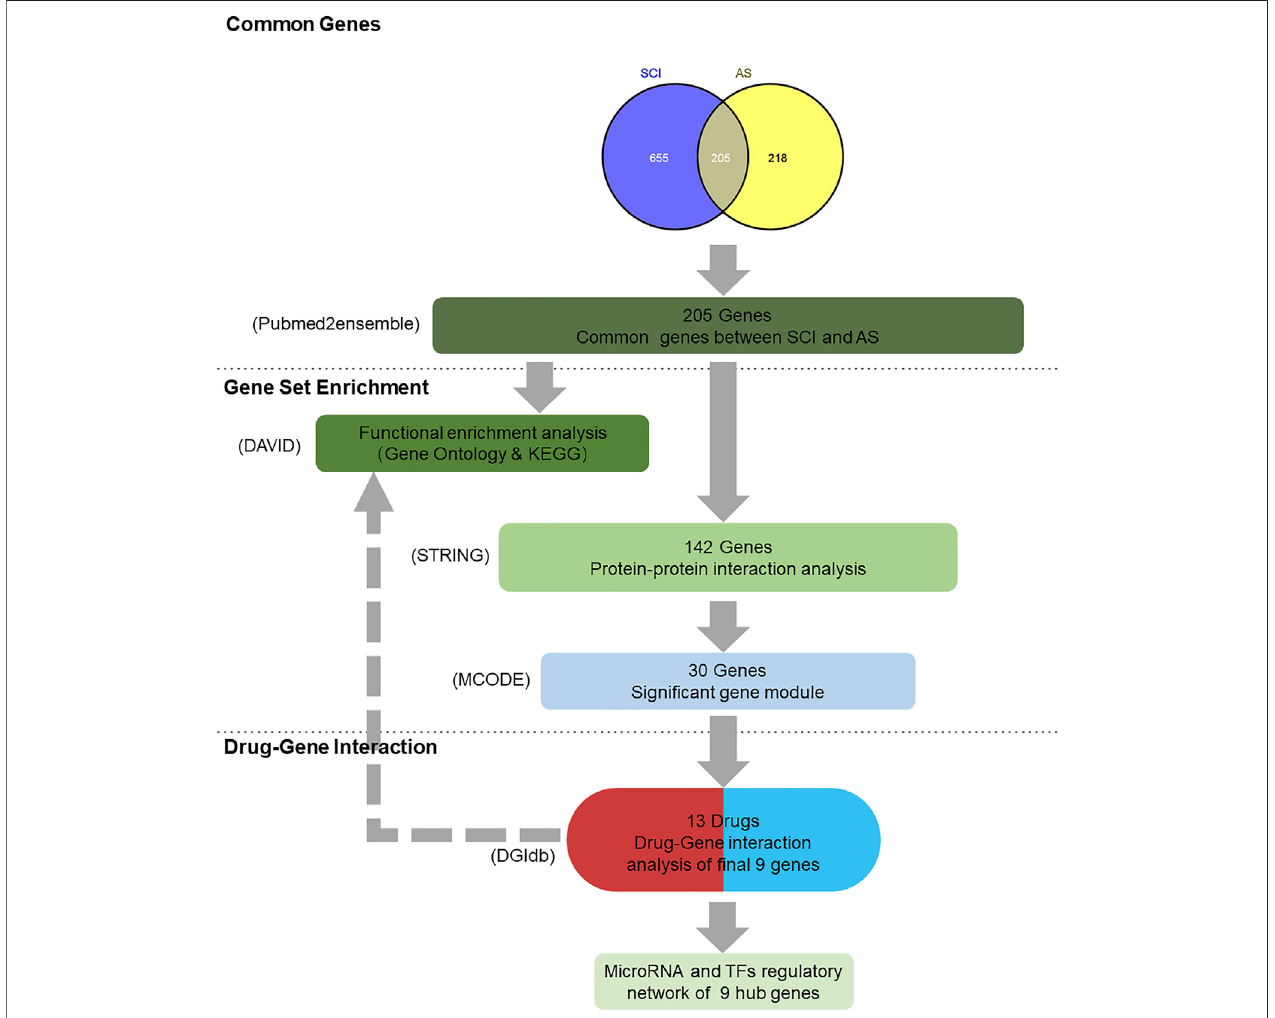
FIGURE1| Summaryofoveralldataminingresult.1)Textmining:860geneswerefoundbyusingthesearchingterm “ spinalcordinjury ” and423geneswerefound via the term “ ankylosing spondylitis ” in pubmed2ensemble, ultimately interacting 205 genes. 2) Gene set enrichment: DAVID functional enrichment analysis was performed using biological process, cellular component, molecular function, and signaling pathways analysis. Next, 30 genes were screened out by using the STRING and Cytoscape software. 3) Drug – gene interaction and functional analysis; 30 genes were imported into the DGIdb and 13 drugs were regarded as the potential medicaltherapy, whereas ninegeneswereselected asthe fi nalgenesthatcompleted thefunctionalanalysis. 4)Ninehub geneswere participating intheanalysisoftheir MicroRNA and TFs regulatory network.